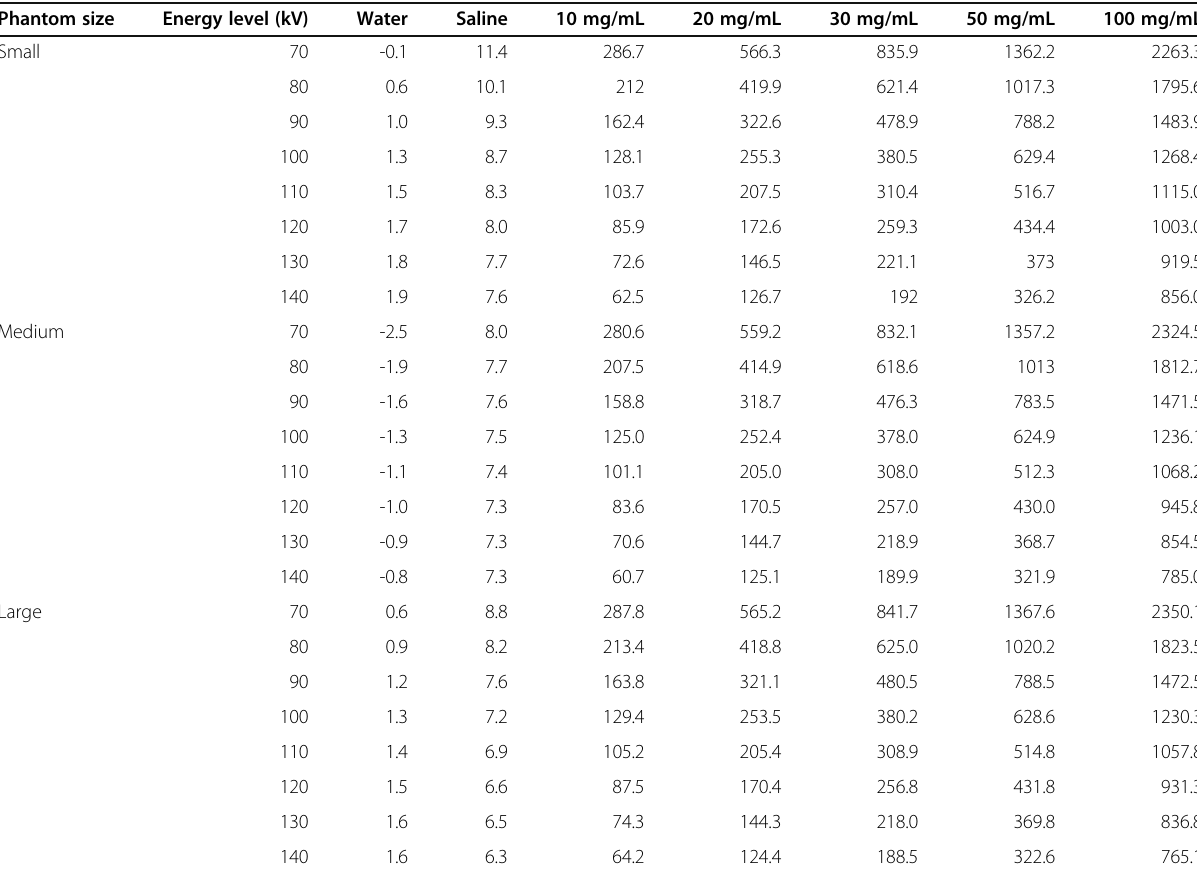
Table 5 Measured HU values in monoenergetic images with Siemens Somatom Drive Phantom size Energy level (kV)